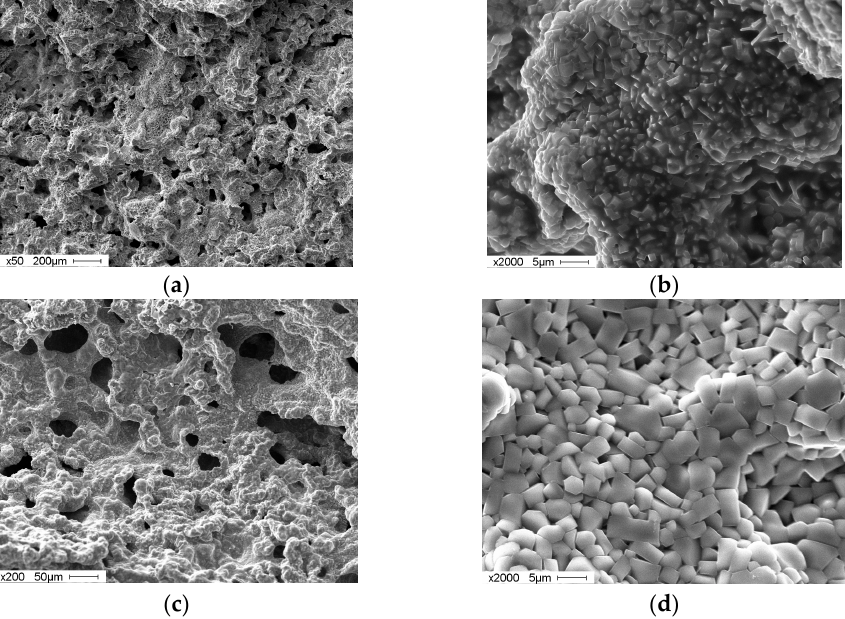
Figure 3. Fractures of SHS samples: ( a , b ) 75% (Ti + 2B) + 25% MgAl 2 O 4 ; ( c , d ) (Ti + 2B).